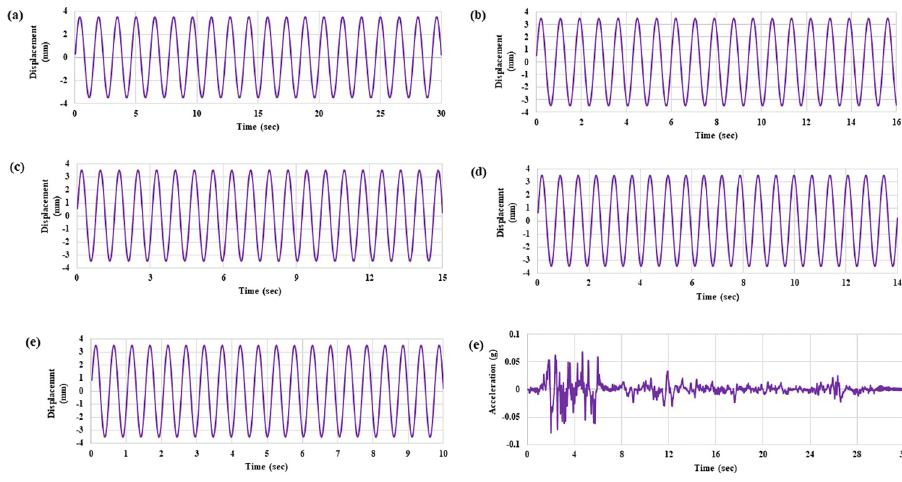
Fig 4. Applied loading acceleration time histories at: (a) 0.65 Hz, (b) 1.17 Hz, (c) 1.3 Hz, (d) 1.43 Hz, (e) 1.95 Hz, and (f) Seismic